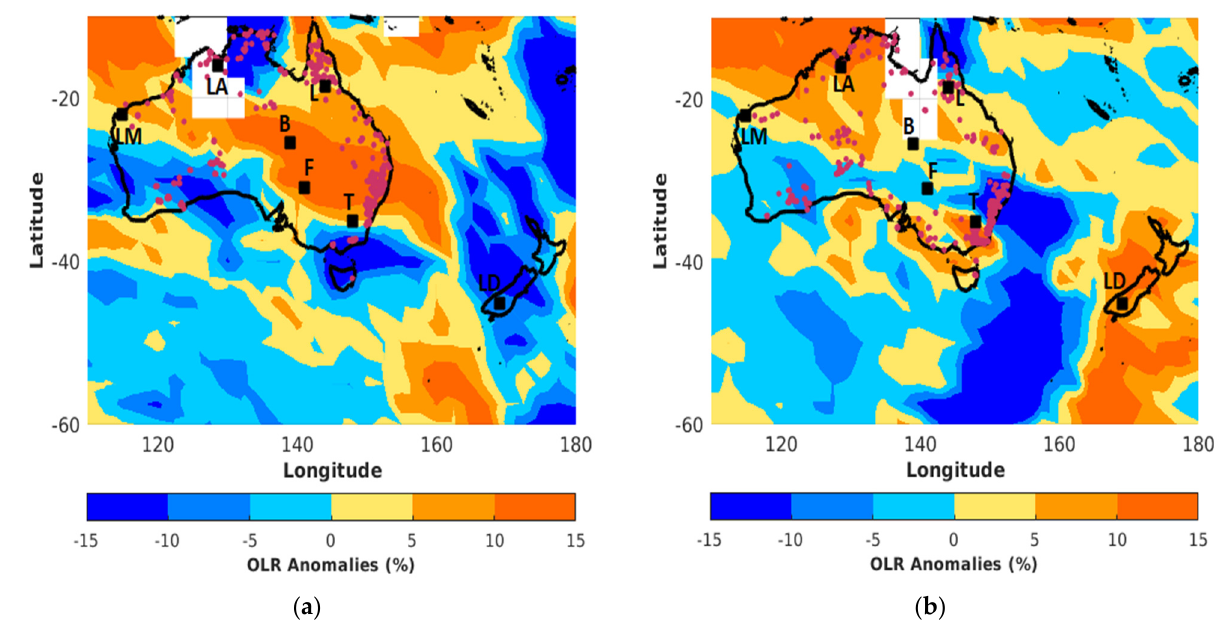
Figure 1. Daily Outgoing Longwave Radiation anomalies obtained from NCEP analysis on ( a ) 19 December 2019 and ( b ) 31 December 2019. The red dots correspond to location of fires obtained from MODIS. The locations of Lake Argyle, Lucinda, Learmonth, Birdsville, Fowlers Gap, Tumbarumba and Lauder sites are indicated by LA, L, LM, B, F, T and LD, respectively.